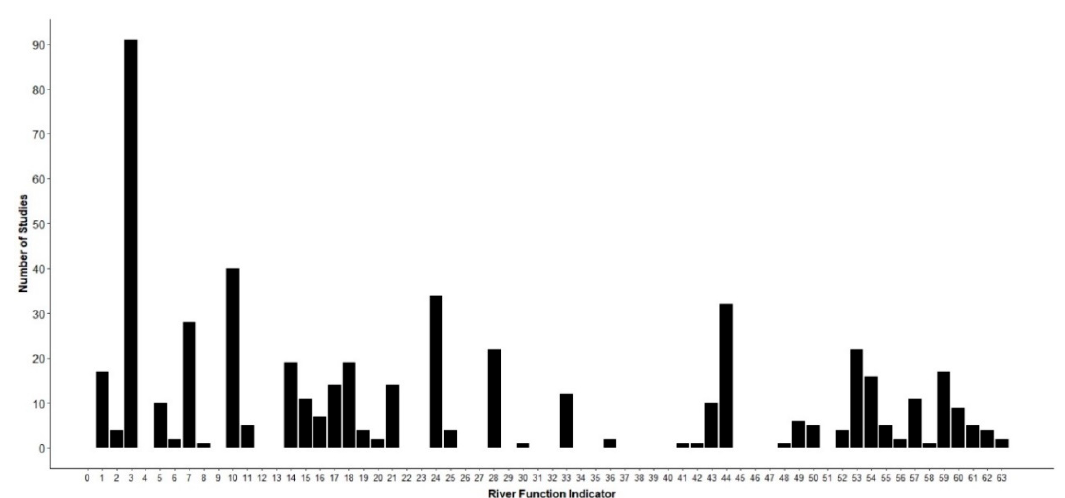
Figure 5. Number of studies requested by RFI for the 23 projects in dataset 1, analyzed with study determination letters.